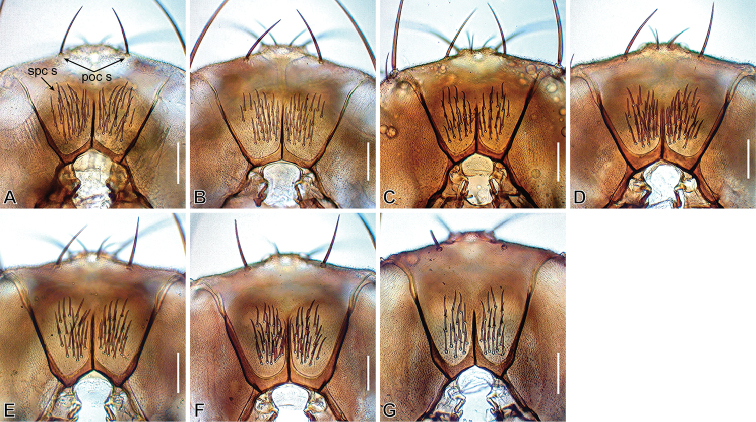
Postocciput (caudal view). Amalayana (Takada) (#03903) Bgracilipalpis sp. n. (paratype #00492) Cpuberula sp. n. (paratype #03366) Dalbipalpis sp. n. (holotype #03908) Eqiongzhouensis sp. n. (paratype #03313) Forthophallata sp. n. (paratype #03905) Gdissimilis sp. n. (holotype #00430). Abbreviations: poc s = postocellar setae, spc s = supracervical setae. Scale bars: 0.1 mm.